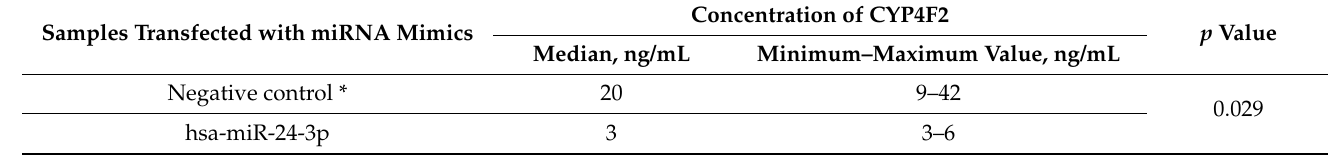
Table 6. Changes in the concentration of CYP4F2 protein after transfection with hsa-miR-24-3p mimic in HUVECs compared to negative control.